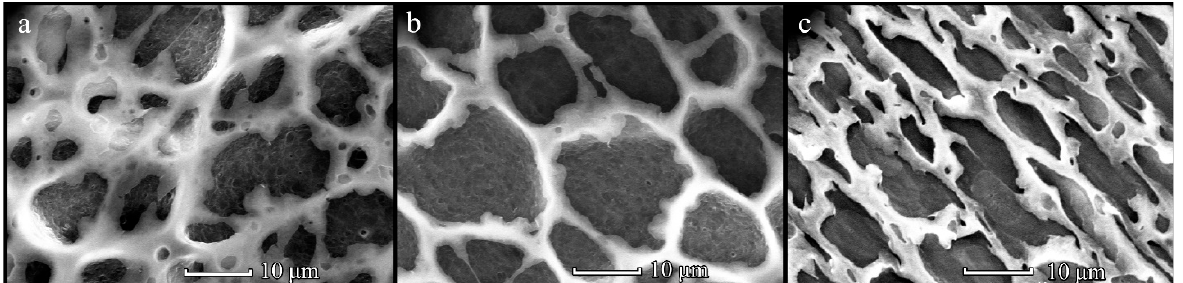
Figure 3. SEM-images of the cells in the PHB1800 films obtained from solution with concentrations of 5 ( a ), 10 ( b ) and 20 ( c ) mg/mL upon L = 1 cm. The solution volume is 450 μ L.